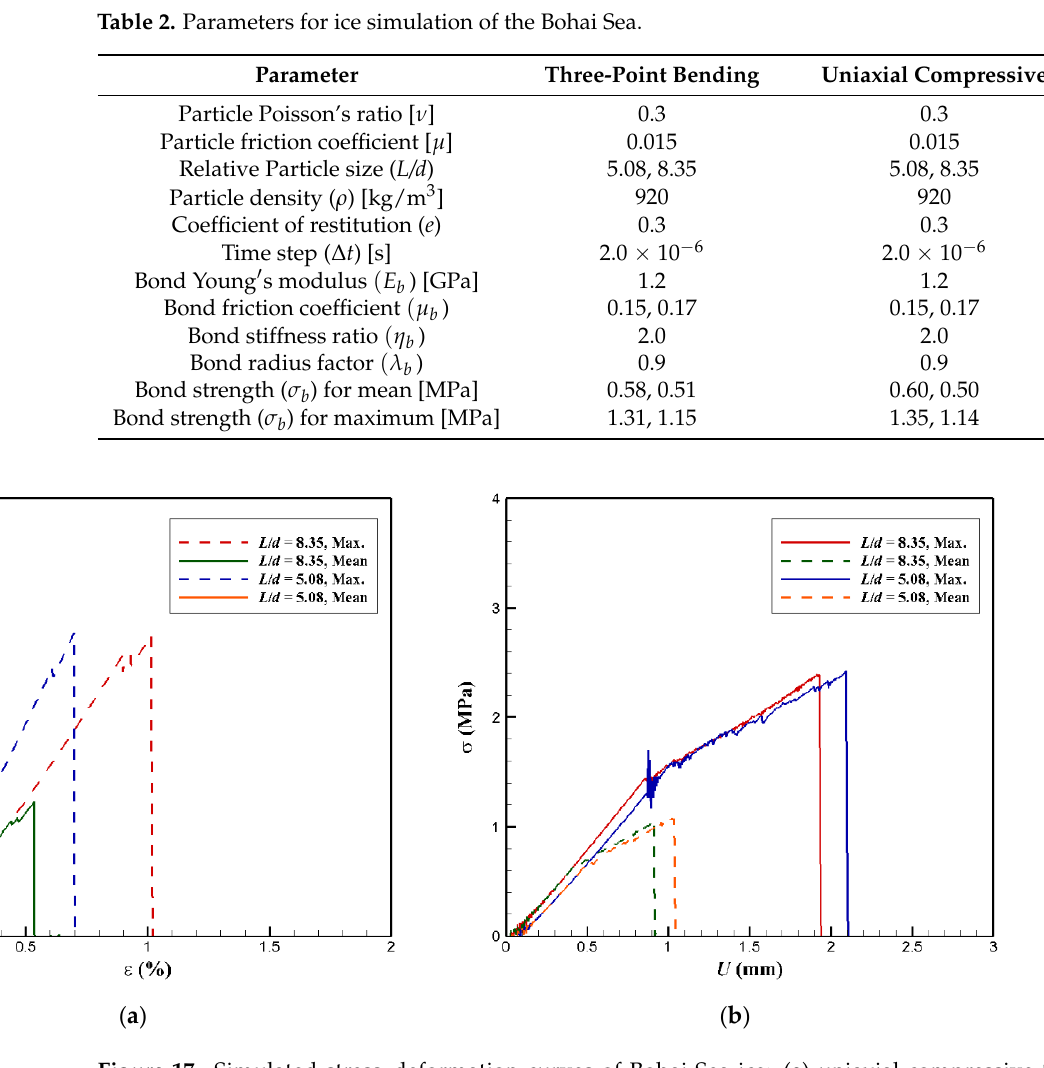
Figure 17. Simulated stress–deformation curves of Bohai Sea ice: ( a ) uniaxial compressive test; ( b ) three-point bending test. Table 2. Parameters for ice simulation of the Bohai Sea.